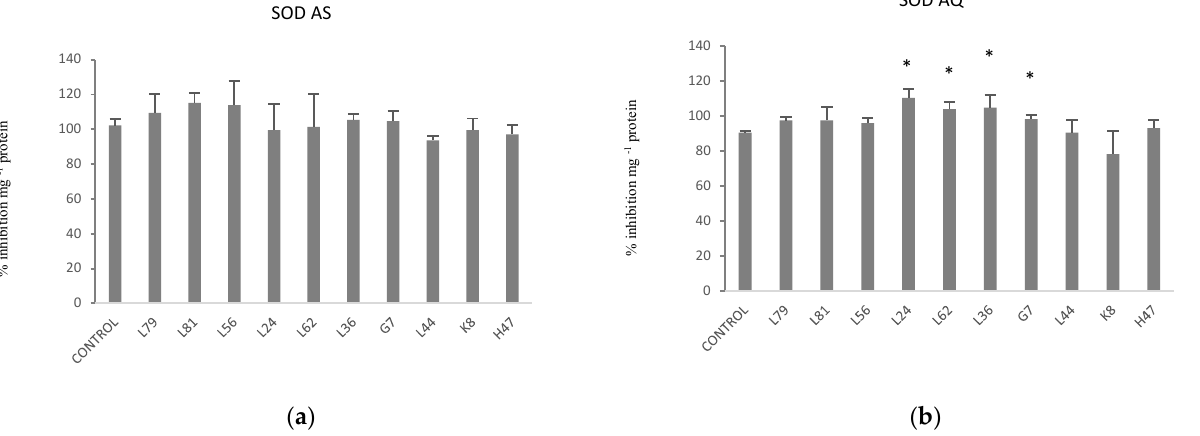
Figure 4. Superoxide dismutase activity (% inhibition mg − 1 protein) in olive leaves ( a ) var. AS and ( b ) var. AQ, inoculated with the 10 PBPB and non-inoculated controls. Values are the average ± SE (n = 3). Asterisks (*) indicate significant differences with the controls according to t student ( p < 0.05). As regards to Ascorbate peroxidase activity (APX), in AS (Figure 5a) a significant decrease with L24 and a significant increase with L44 were registered. In AQ, a non-significant increase with L79 was registered.